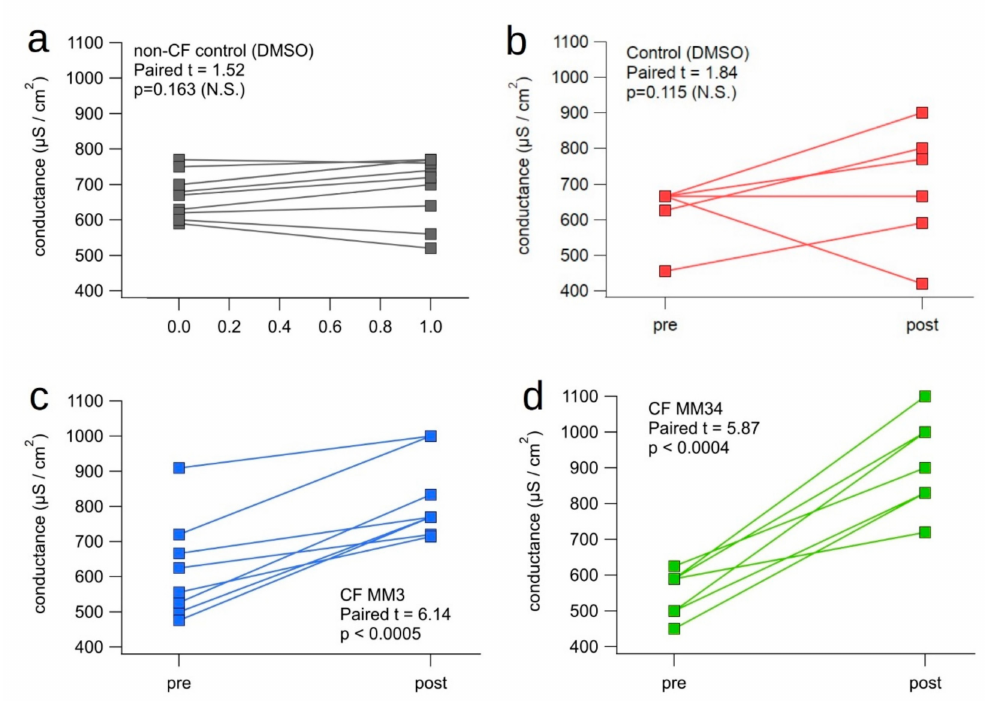
Figure 3. Transepithelial electrical conductance (TEEC) modified by the anionophores-driven transport in CF-HBEC. ( a ) HBEC monolayers derived from 2 non-CF donors treated with 0.1% DMSO are presented as control ( n = 10). HBEC monolayers derived from 2 homozygous F508del-CFTR patients, treated for 24 h with ( b ): 0.1% DMSO ( n = 6); ( c ): 0.25 µ M of MM3; ( d ): 0.25 µ M of MM34 ( n = 9). Conductance was measured before (pre) and after treatment (post). The Student’s paired- t test parameter and the corresponding p value are indicated in each panel. Table 2. Di ff erences of the conductance (in µ S / cm 2 ) measured before and after the treatment with the anionophores. The di ff erence of the average of each group against 0 was determined with the Student’s t test; di ff erence is considered significant for p < 0.05. DMSO MM3 MM34 average